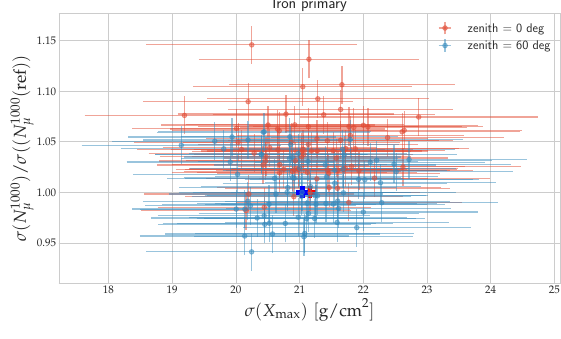
Figure 6. Results of simulations in [ σ ( X max ), σ ( N 1000 ) /σ ( N 1000 (ref))], iron primary. Note the di ff erence µ µ in scale compared to Fig. 3.